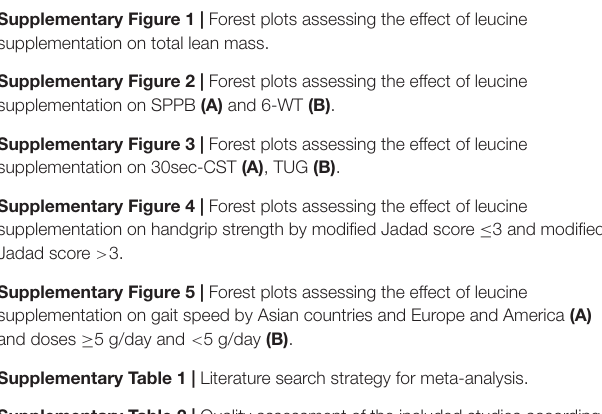
Supplementary Table 1 | Literature search strategy for meta-analysis. Supplementary Table 2 | Quality assessment of the included studies according to modified Jadad